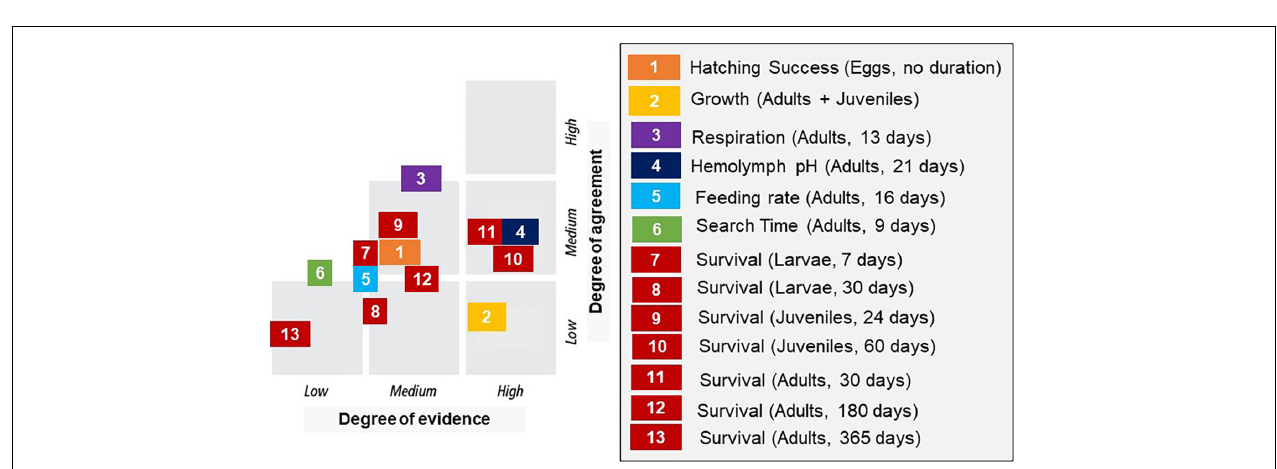
FIGURE 2 | Synthesis of thirteen thresholds, characterized by its magnitude (pH) and duration of exposure response. The thresholds were determined based on expental data using breakpoint analyses and linear regression, and a final step involving their interpretation through expert consensus. Number of studies per effect threshold were as follows: hatching success = 11, growth rate = 10, adult respiration = 12, hemolymph pH = 17, feeding rate = 4, search time = 4, 30-day adult survival = 6; 180-day adult survival = 3; 24-day juvenile survival = 6, 7-day larval survival = 6; 30-day larval survival = 11 studies. Details on thresholds and studies are found in Table 2